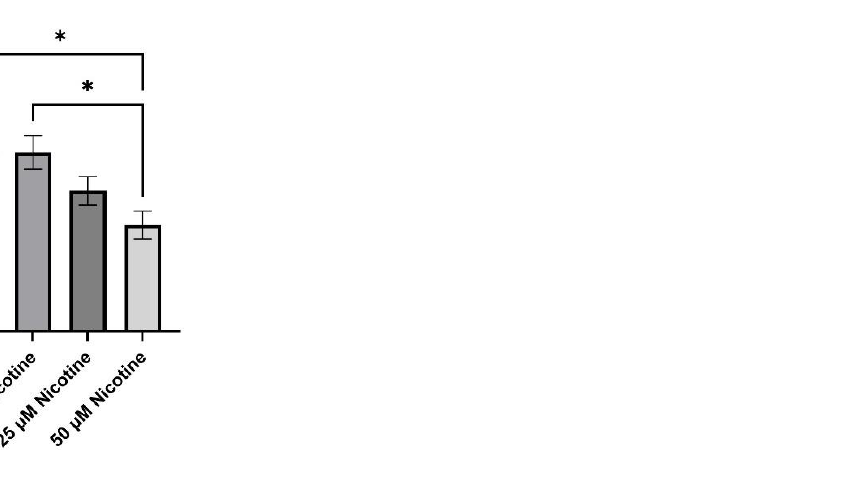
9 of 16 Figure 6. Embryonic nicotine exposure reduces the time fish spend near a live shoal. ( A ) Bars rep- resent the time spent in each of the 10 zones during the first 10 min of habituation and ( B ) the last 10 min of the behavioral session when the stimulus is visible. During habituation, the fish swam back and forth in the tank and spent more time in the zones nearest either end of the tank. During the stimulus, fish from all groups spent more time in zone 1; however, the fish from 50 µM nicotine group spent 23% less time in zone 1 than the control group. To quantify the effect of nicotine on social behavior, we compared the average time spent in the zone closest to the stimulus across groups (zone 1). As shown above, all groups spent most of the time in zone 1 near the stimulus. The control and fish exposed to 12.5 µM nicotine spent 59% (SEM ± 7.8) and 69% (SEM ± 5.6) of the time in zone 1, respectively. However, fish exposed to 25 and 50 µM nicotine spent 47% (SEM ± 4.7) and 36% (SEM ± 4.6) of the time in zone 1, respectively. An ANOVA test showed significant